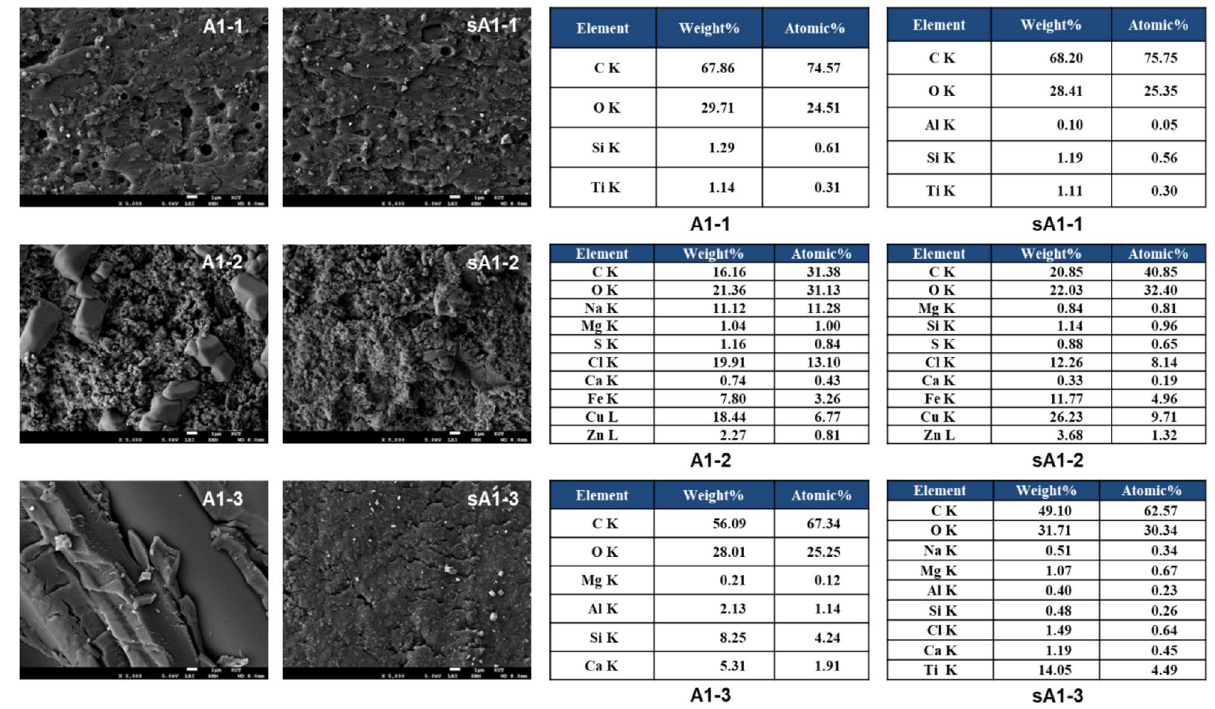
Figure 2. SEM–EDS image of Case I